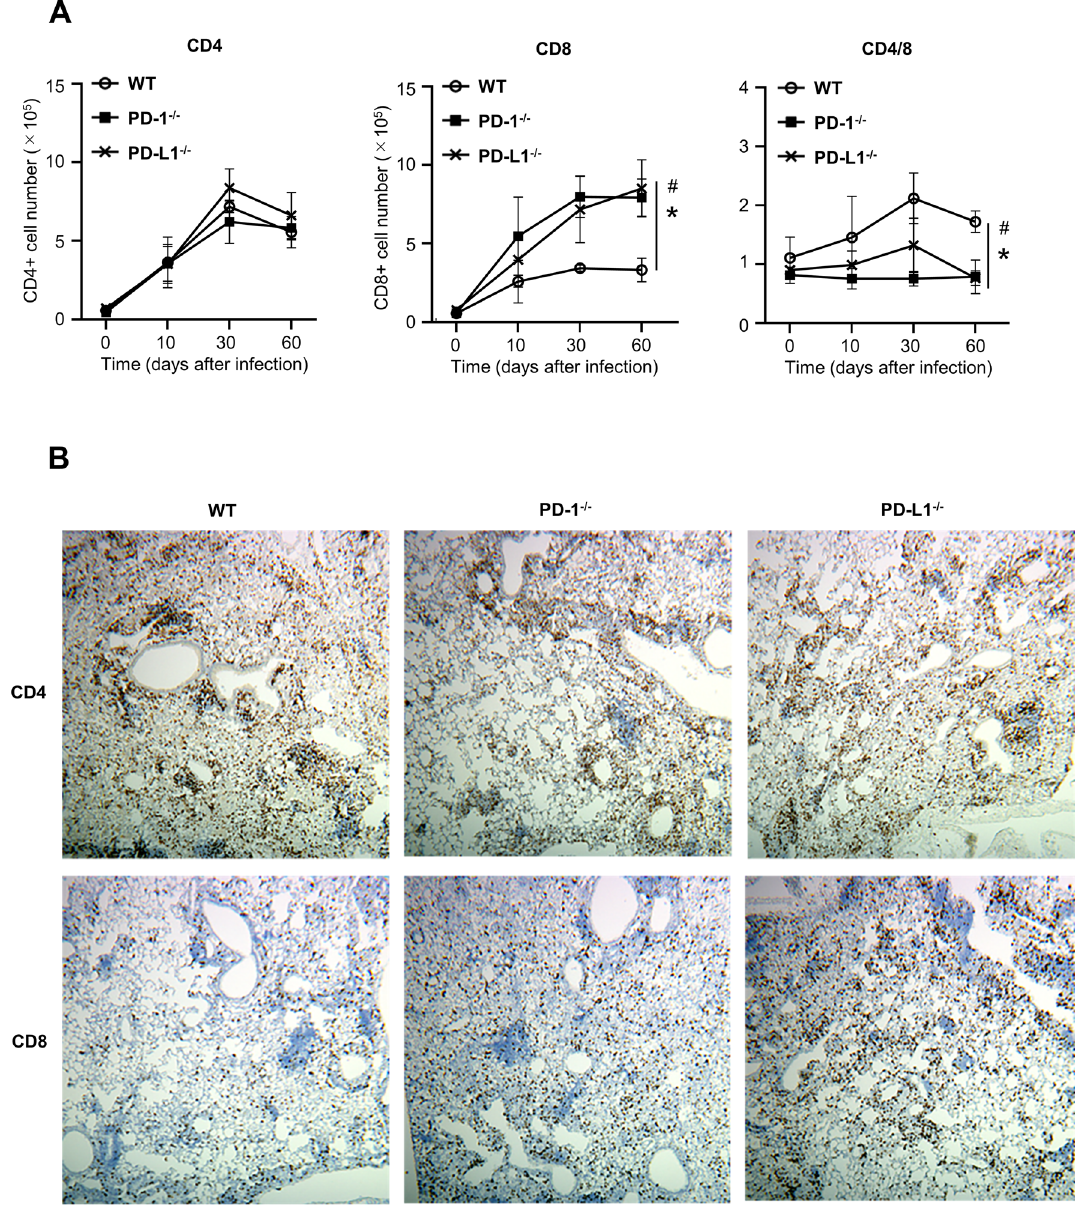
Figure 3. Pulmonary inflammatory cell analysis of wild-type, PD-1 −/− , and PD-L1 −/− mice after MAC infection. ( A ) The numbers of CD4 and CD8-positive cells in the lungs of wild-type, PD-1 −/− , and PD-L1 −/− mice 0, 10, 30, and 60 days after intranasal inoculation of 1 × 10 7 CFU of MAC. The ratio of CD4/CD8 was also calculated. ( B ) Representative photographs of immunostaining for CD4 and CD8 in the lungs of wild-type, PD-1 −/− , and PD- L1 −/− mice 60 days after MAC infection (× 100). The experiments were performed in duplicate with four mice in each group. Data are expressed as means ± SEM. Significance was defined as a P value of < 0.05. *Significant difference between wild-type mice and PD-1 −/− mice (P < 0.05). # Significant difference between wild-type mice and PD-L1 −/− mice (P <